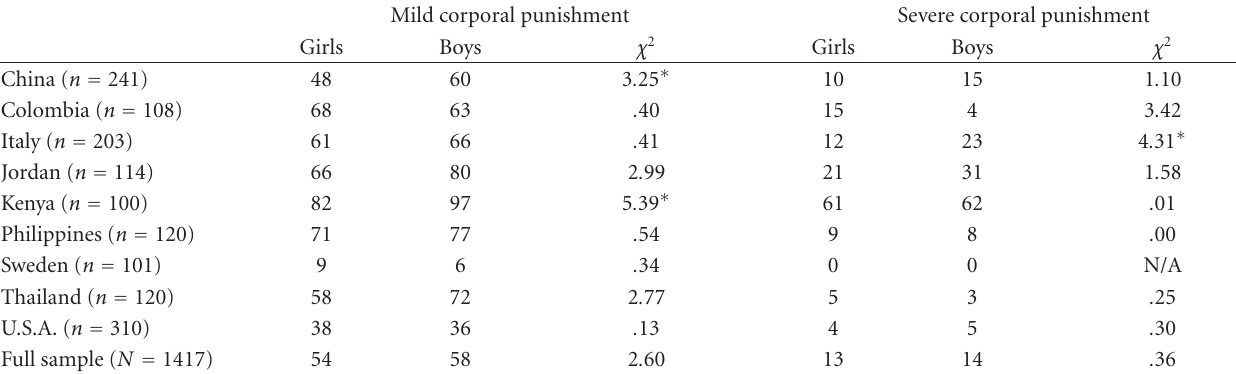
Table 1: Percentages of parents reporting two types of corporal punishment in the last month.